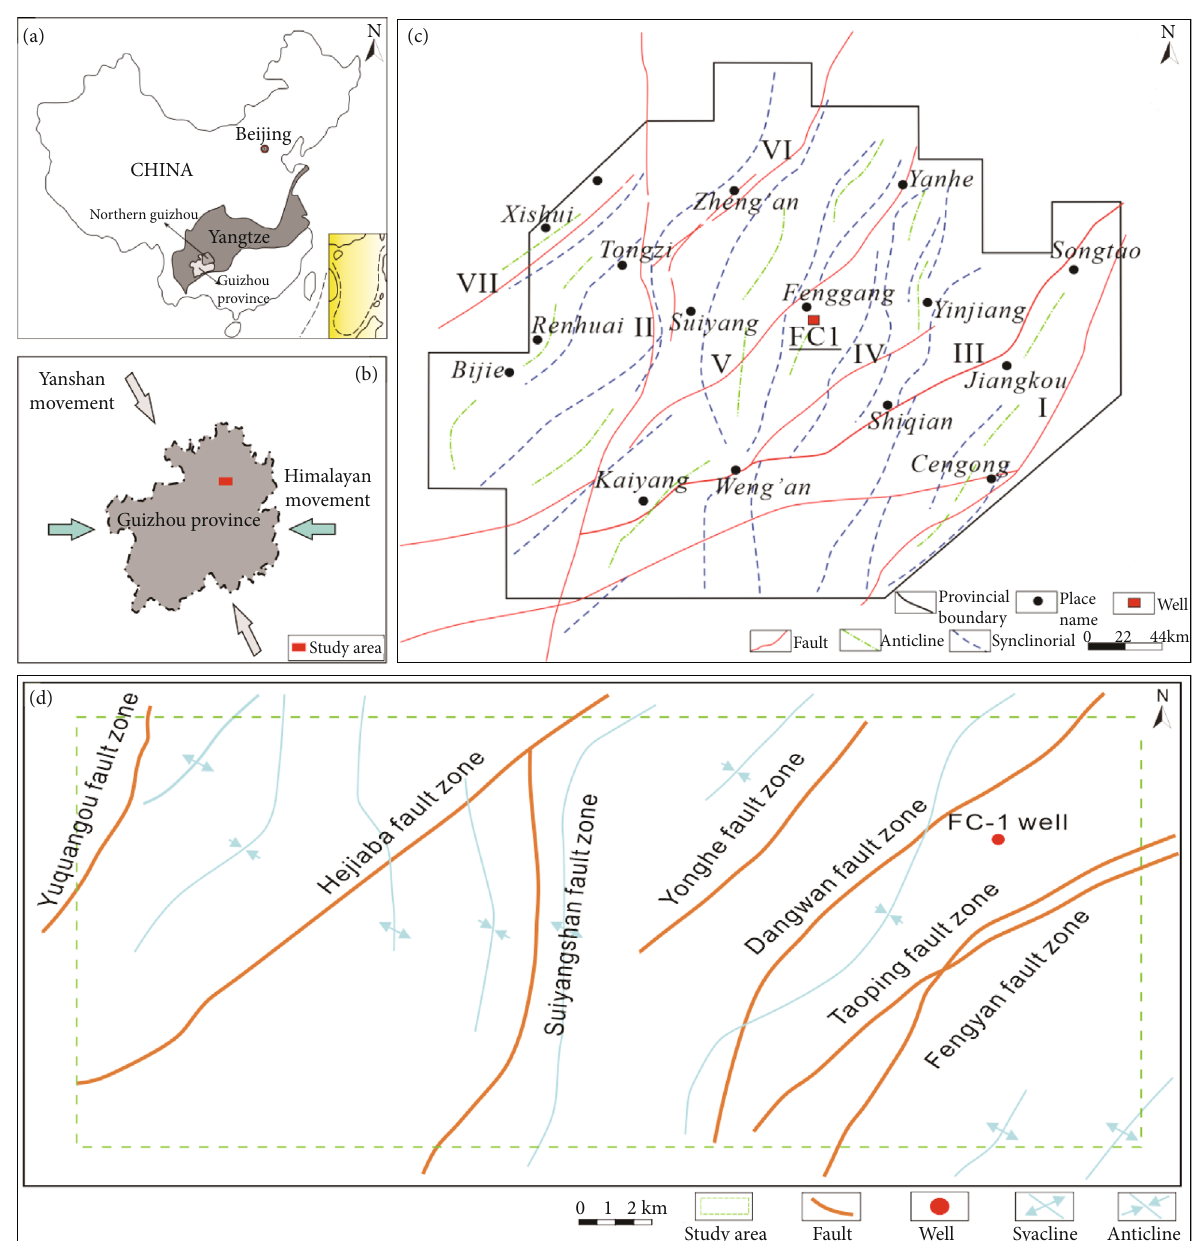
Figure 1: Regional tectonic geological map of the study area: (a) the location of the study area, (b) the main tectonic movement, and (c, d) the tectonic distribution of the study